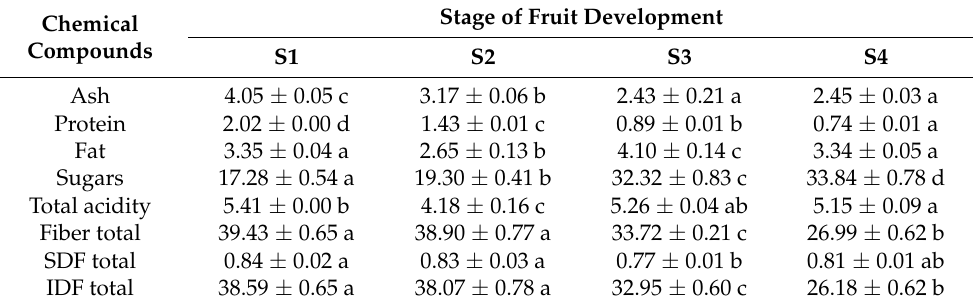
Table 1. The content (g/100 g DW) of the main nutrients of chokeberry fruits at various stages of development. Stage of Fruit Development Chemical Compounds S1 S2